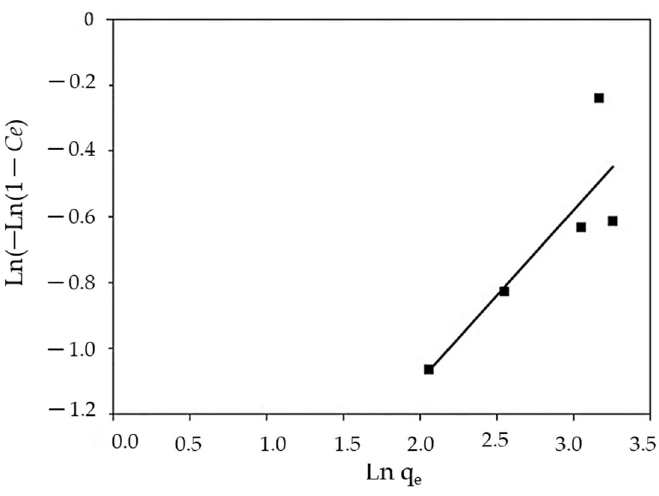
Figure 15. Linear Henderson isotherm for MBD sorption.